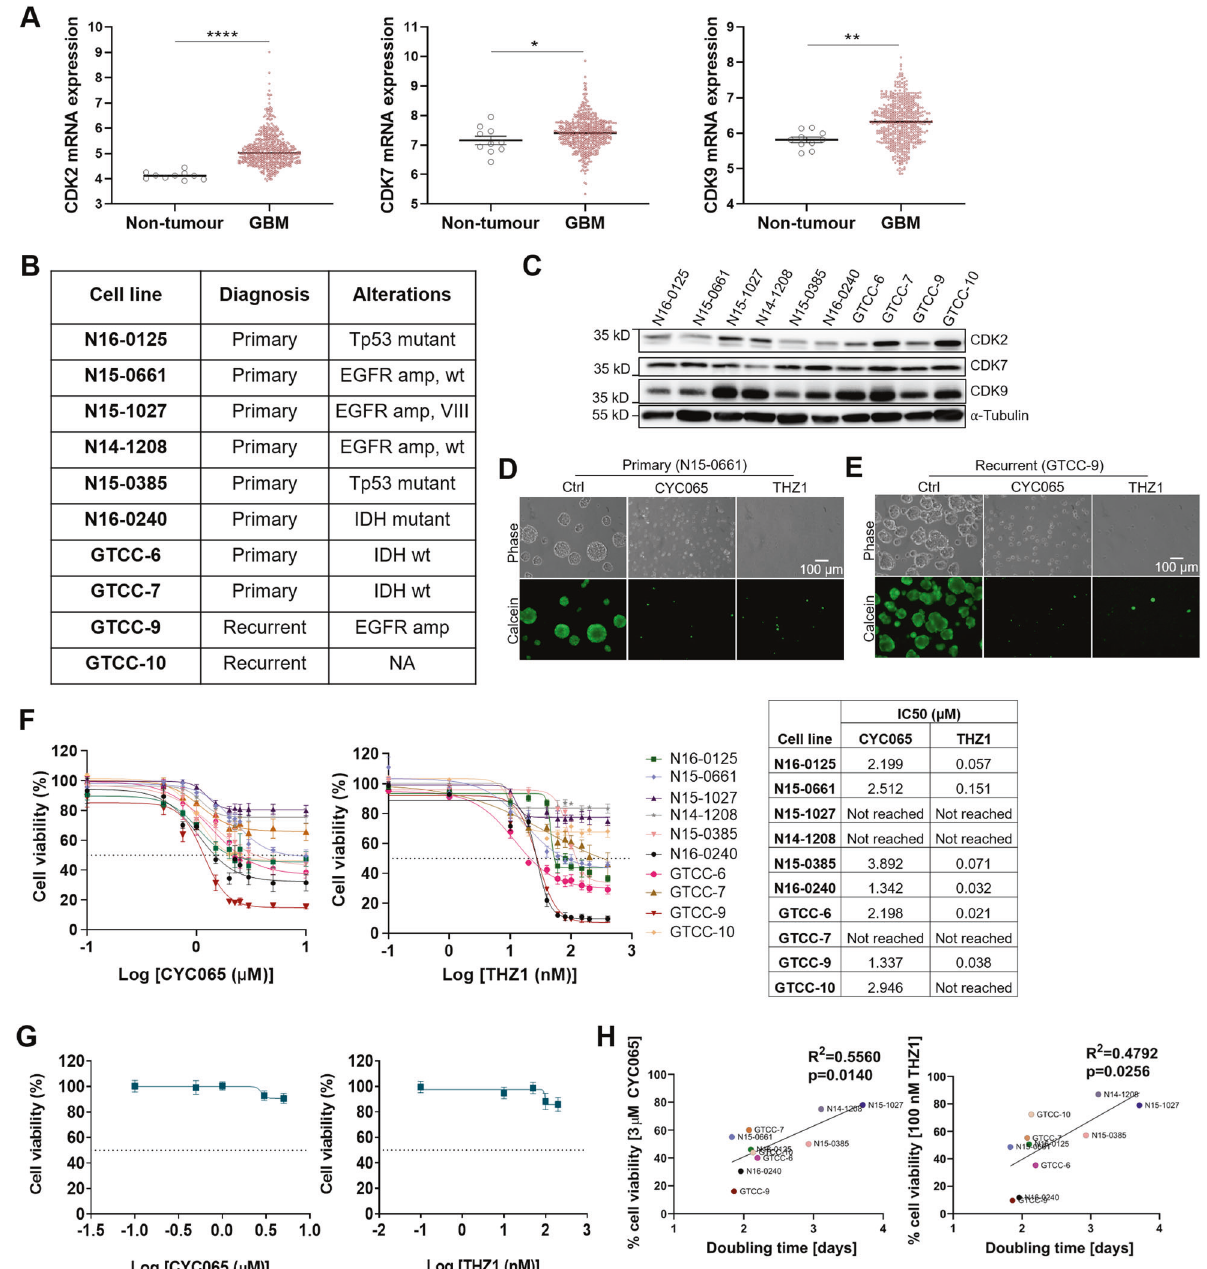
Fig. 1 Targeting CDK2/9 or 7 in GBM causes loss of cell viability whilst sparing neuronal cells. A Publicly available TCGA data were analysed to study mRNA expression of CDK2, 7 and 9 in GBM patient tumour tissues compared to non-tumour tissue. A two-tailed unpaired t -test was used to determine signi fi cance, whereby **** p < 0.0001; ** p < 0.01; * p < 0.05. Data from a total of 538 samples were analysed. B Molecular characteristics of ten patient-derived GBM patient-derived cultures used in this study. C CDK2, 7, and 9 protein expression levels in 3-D culturing system were analysed using Western blot. α -Tubulin was used as a loading control. Western blot analysis is performed in n = 3 biological replicates and representative blots are shown here. D Gliomasphere morphology and viability was followed using Calcein-AM staining 72 h post-treatment with DMSO control, 3 μ M CYC065 and 100 nM THZ1 in primary gliomasphere culture — N15-0661. E Gliomasphere morphology and viability was followed using Calcein-AM staining 72 h post-treatment with DMSO control, 3 μ M CYC065 and 100 nM THZ1 in recurrent gliomasphere culture — GTCC-9. D , E Images were taken with an Eclipse TE300 inverted microscope (scale bar = 100 μ m). N = 3 independent experiments performed in triplicate for each condition. F Cell viability was measured 72 h post-treatment with increasing concentrations of CYC065 and THZ1 in patient-derived gliomaspheres using WST-1 viability assay. Corresponding IC50 values are given in the table. Data are expressed as mean ± SEM. N = 3 independent experiments performed in triplicate. G Cell viability was determined using WST-1 viability assays in mouse primary cortical neurons 96 h post-treatment with increasing concentrations of CYC065 and THZ1. Data are expressed as mean ± SEM. N = 3 independent experiments performed in triplicate. H Correlation between gliomasphere cell doubling time and treatment response to 3 μ M CYC065 and 100 nM THZ1 was calculated using Pearson correlation coef fi cient. N = 3 independent experiments